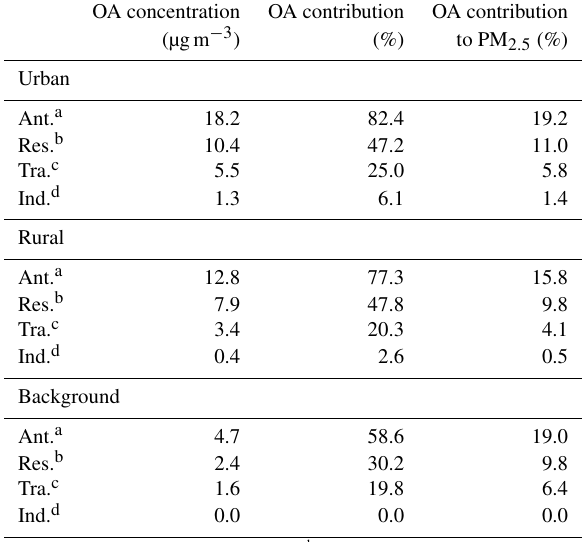
Table 5. OA concentrations and contributions and OA contributions to PM 2 . 5 from anthropogenic emissions averaged over the simula- tion period at urban, rural, and background